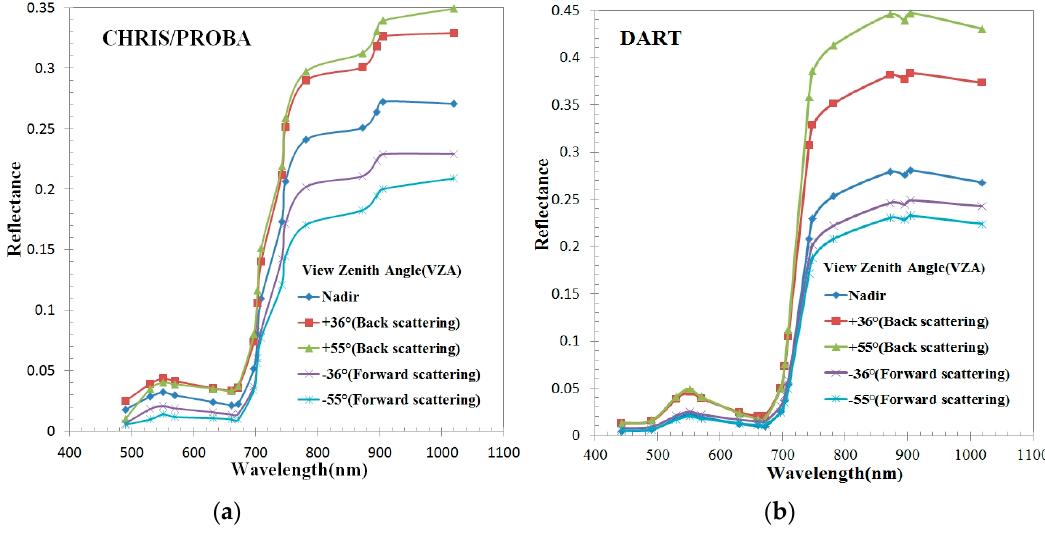
Figure 4. ( a ) Measured CHRIS/PROBA reflectance spectra; ( b ) simulated DART reflectance spectra of Howland for CHRIS/PROBA view zenith angles and directions.